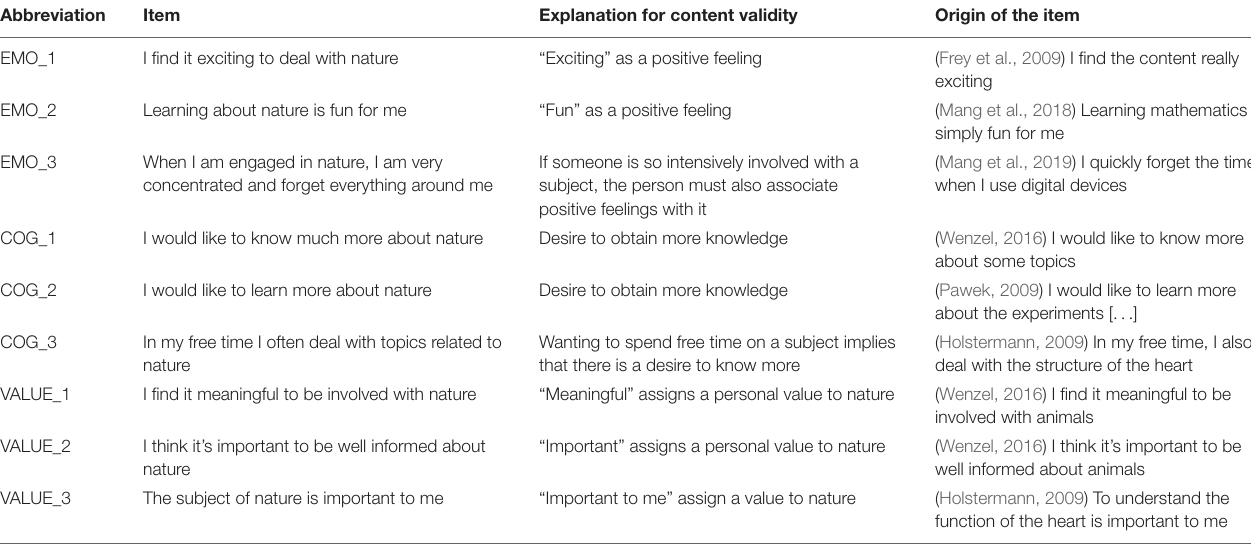
TABLE 1 | The nine items selected based on the construct of interest.